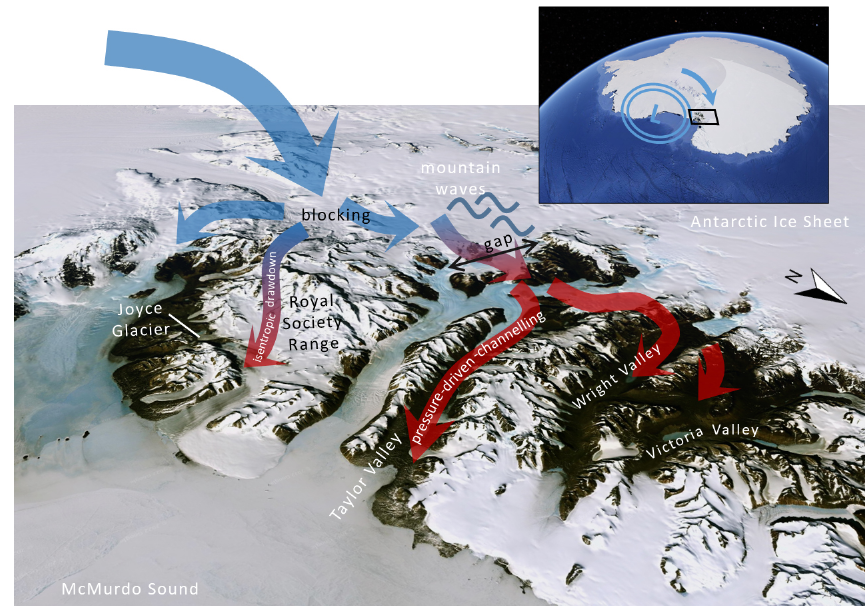
Figure 11. Overview of local processes that lead to foehn conditions in the MDV. “L” represents the synoptic low-pressure system. The thick blue arrow represents the synoptic flow as visualized in the subplot. The smaller arrows show the local airflow, with the colour transition from blue to red indicating the warming and drying of the flow (© Google